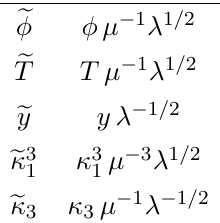
Table 1 . Notation for the model parameters, and de(cid:12)nition of rescaled parameters which are dimensionless in units of energy and ~